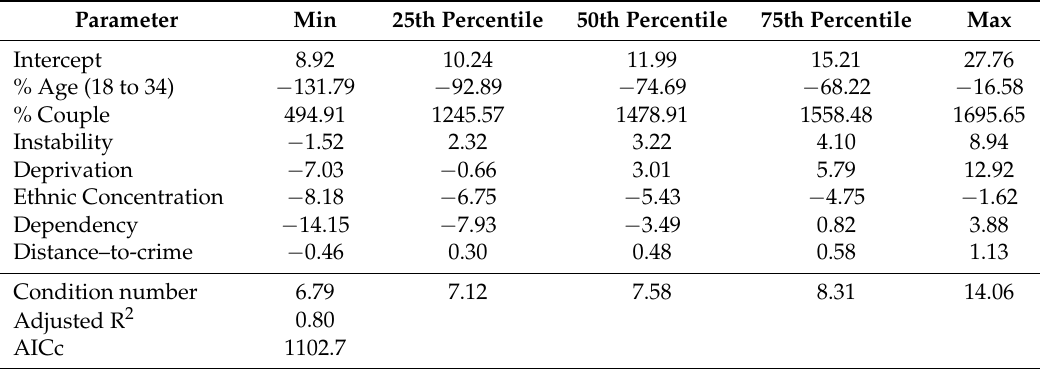
Table 5. Geographical weighted regression (GWR) results for property